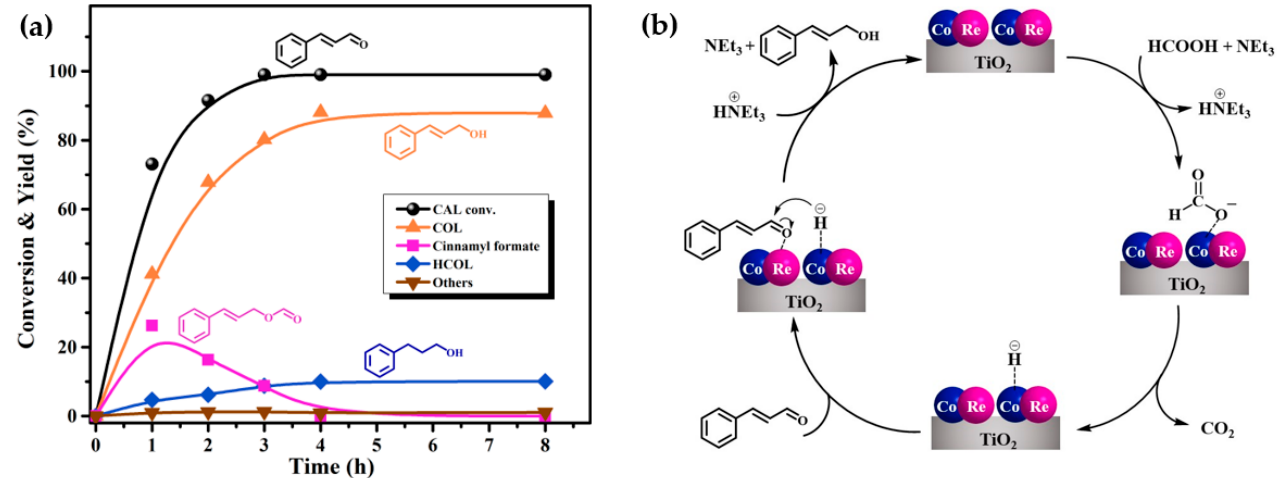
Figure 6. ( a ) Time courses of the hydrogenation of CAL to COL over Co 1 Re 1 /TiO 2 . Reaction condi- tions: 3 mmol CAL, CAL:FA:NEt 3 = 1:2:2, 10 mL THF, 80 mg Co 1 Re 1 /TiO 2 catalyst, 140 °C. Others: allylbenzene, isopropenylbenzene, 1,1 ′ -(1,5-hexadiene-1,6-diyl)bisbenzene and other unknown by- products. ( b ) The proposed mechanism for the hydrogenation of CAL to COL over Co 1 Re 1 /TiO 2 .